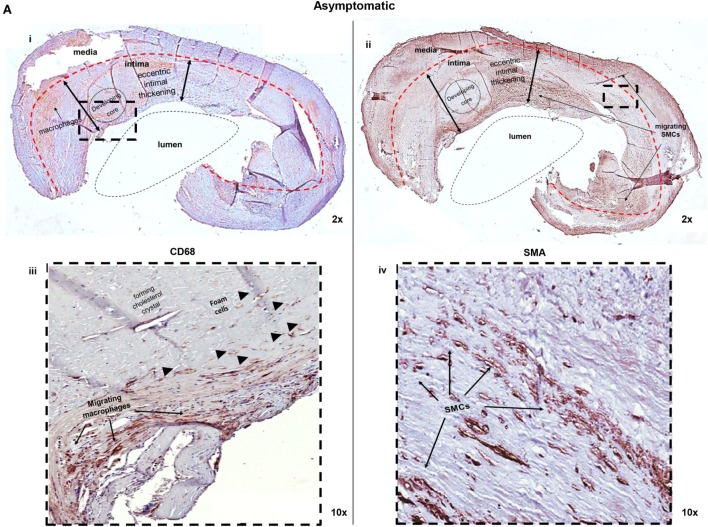
Macrophage/foam cell and SMCs content is decreased in (A) asymptomatic and increased in (B) symptomatic plaques. (A) Low (2×) (i,ii) and high (10×) (iii,iv) magnifications of the IC portion of a plaque from an asymptomatic patient, where the central lumen, intimal side, and media layer of the plaque are visible. Sections were stained with an anti-CD68 Ab (i,iii) to identify macrophage accumulation. Macrophages were identified migrating toward the developing core with little detection of foam cells (head arrows). Sections were also stained with an anti-SMA Ab (ii,iv). SMCs (arrows) display migratory activity, moving from media to intimal layer. (B) Low (2×) (i,ii) and high (10×) (iii,iv) magnifications, of the IC portion of a plaque from a symptomatic patient, identifying a reduced lumen compared to asymptomatic plaques (i), an intimal side and a media layer of the plaque. The intimal thickness is also increased compared with asymptomatic plaques (i,iii). Macrophages (arrows), detected with an anti-CD68 Ab, are evident in the necrotic core and foam cell accumulation (head arrows) are predominant. (ii,iv) Extensive SMCs activity (head arrows), detected with an anti-SMA Ab, is evident primarily in the intima layer. Pictures were captured using TLM (2× and 10× magnifications). Representative images of N = 3 independent staining are displayed here.